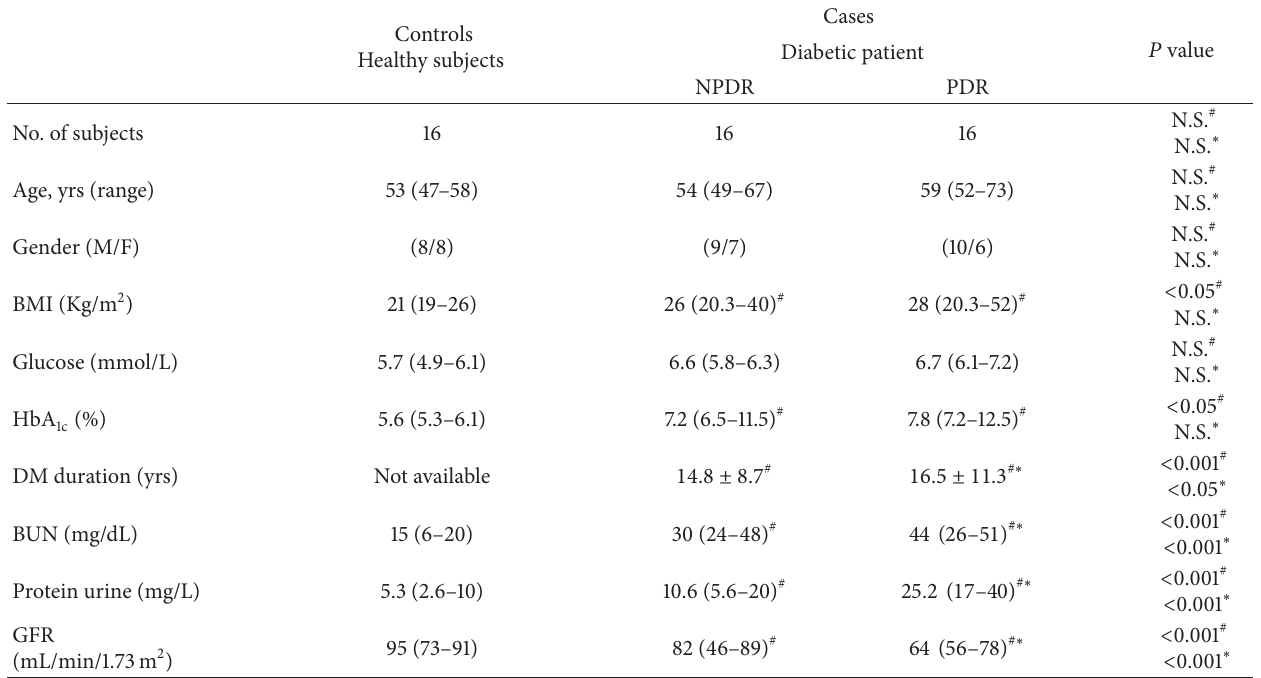
Table 1: Demographic and laboratory results of cohort.